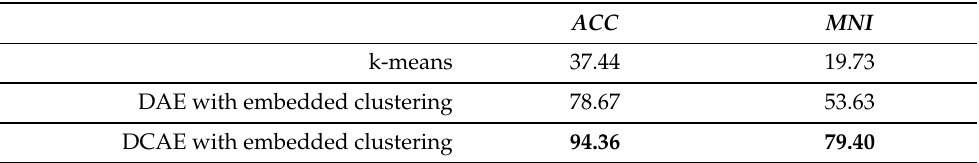
Table 2. Experimental results of clustering quality, reporting averaged performance across 5-fold cross-validation on three methods on the